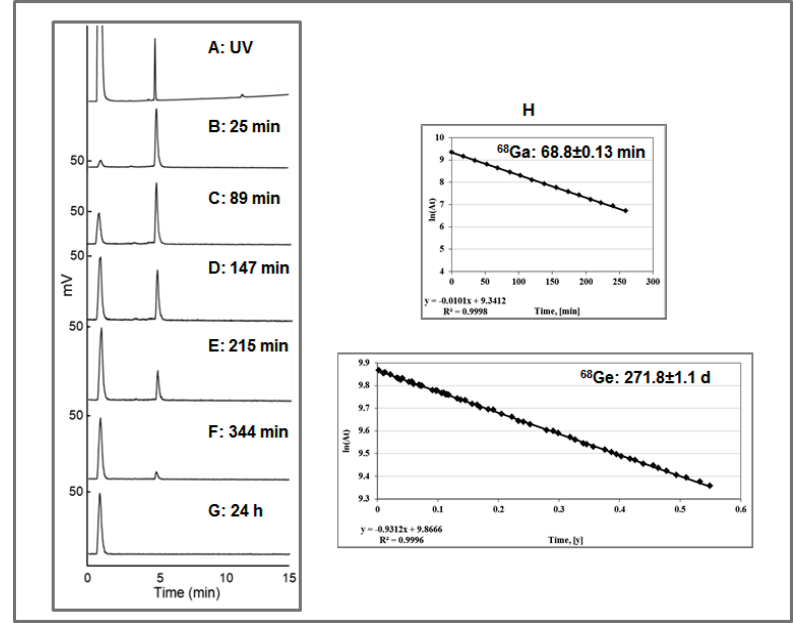
Figure 22. ( A ) UV-HPLC chromatogram of the authentic reference, [ Nat